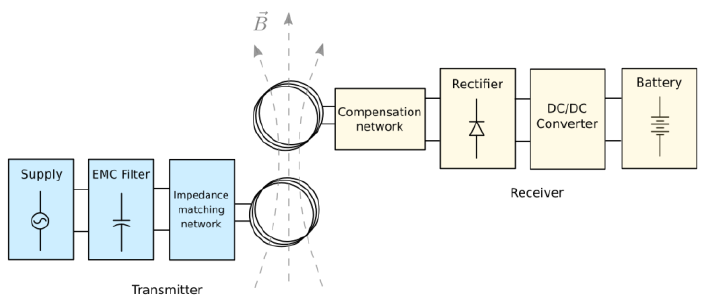
Figure 1. Scheme of a WPT system.